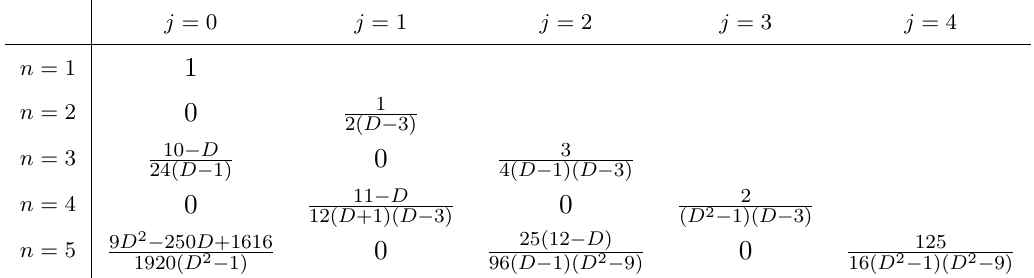
Table 1 . Values of B D for the type-I amplitude with low n and j . Note that all of them are n,j non-negative for D 6 10 and, e.g., B D indicates violation of unitarity for D > 10 3 , 0